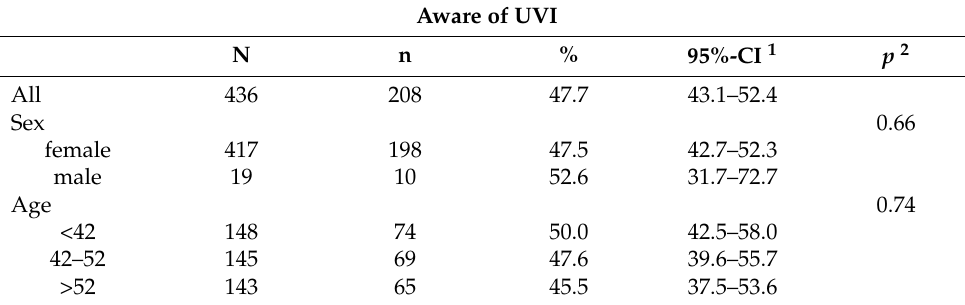
Table 1. Awareness of the UVI among directors of kindergartens (N = 436). Absolute frequencies (N = sample size; n = number of affirmative answers), proportions (%) accompanied by confidence intervals (95%-CI) and p -values ( p ) comparing proportions between subgroups.